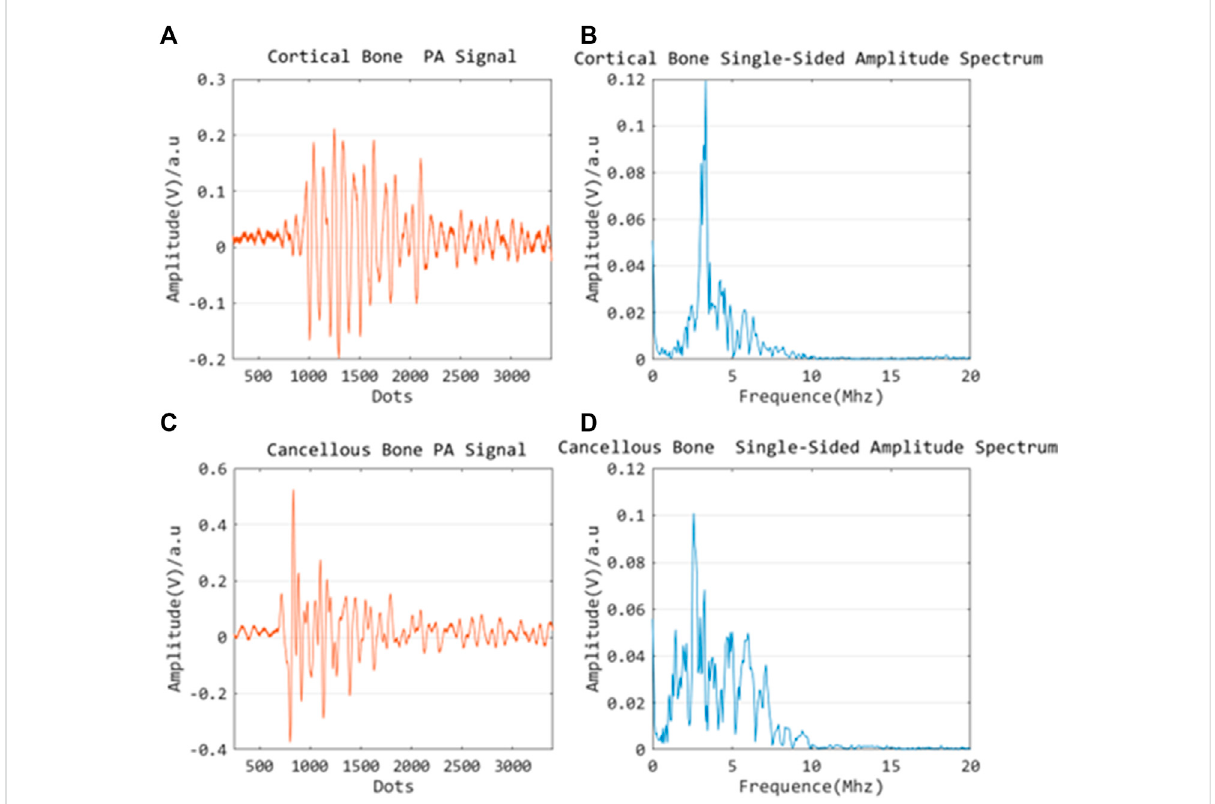
FIGURE 10 Time domain PA signal characterization of cortical bone (A) and cancellous bone (C) ; Frequency domain PA signal characterization of cortical bone (B) and cancellous bone (D) .